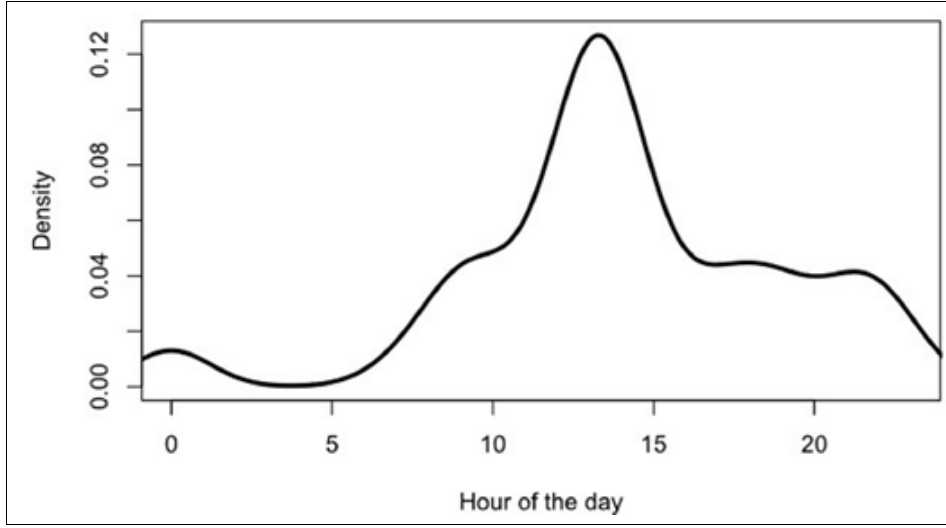
Figure 3: Density plot of number of comments per hour (N =